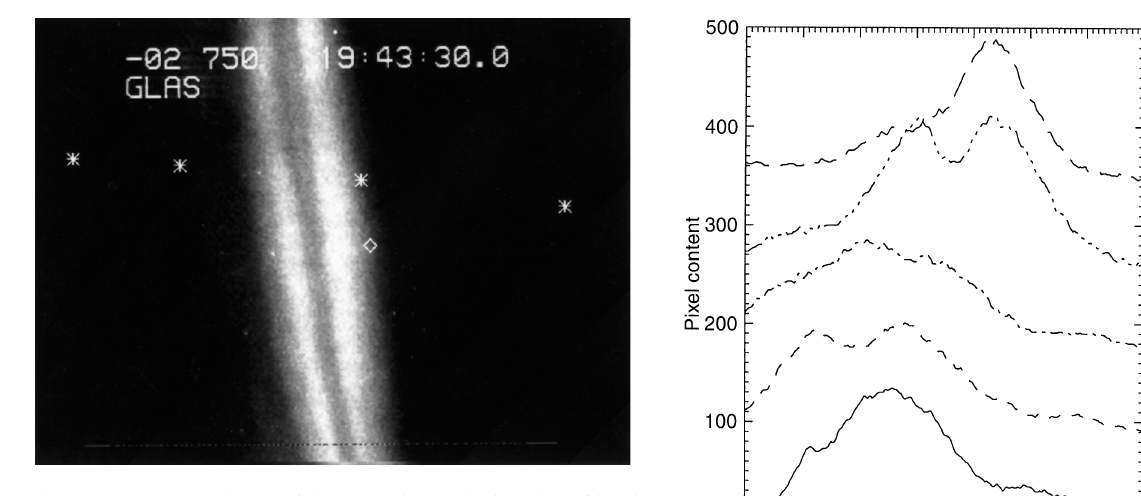
Fig. 4. CCD camera image of the auroral arc. The location of local magnetic zenith ( diamond ) and the position of the radar electric field measurements traced down to 110-km altitude ( asterisk ) are marked. EISCAT measured the plasma drift vectors at these positions (from south to north, left to right ) 19:38:40 — 19:40:40, 19:41:10 — 19:42:10, 19:42:30 — 19:43:40 and 19:44:10 — 19:45:50